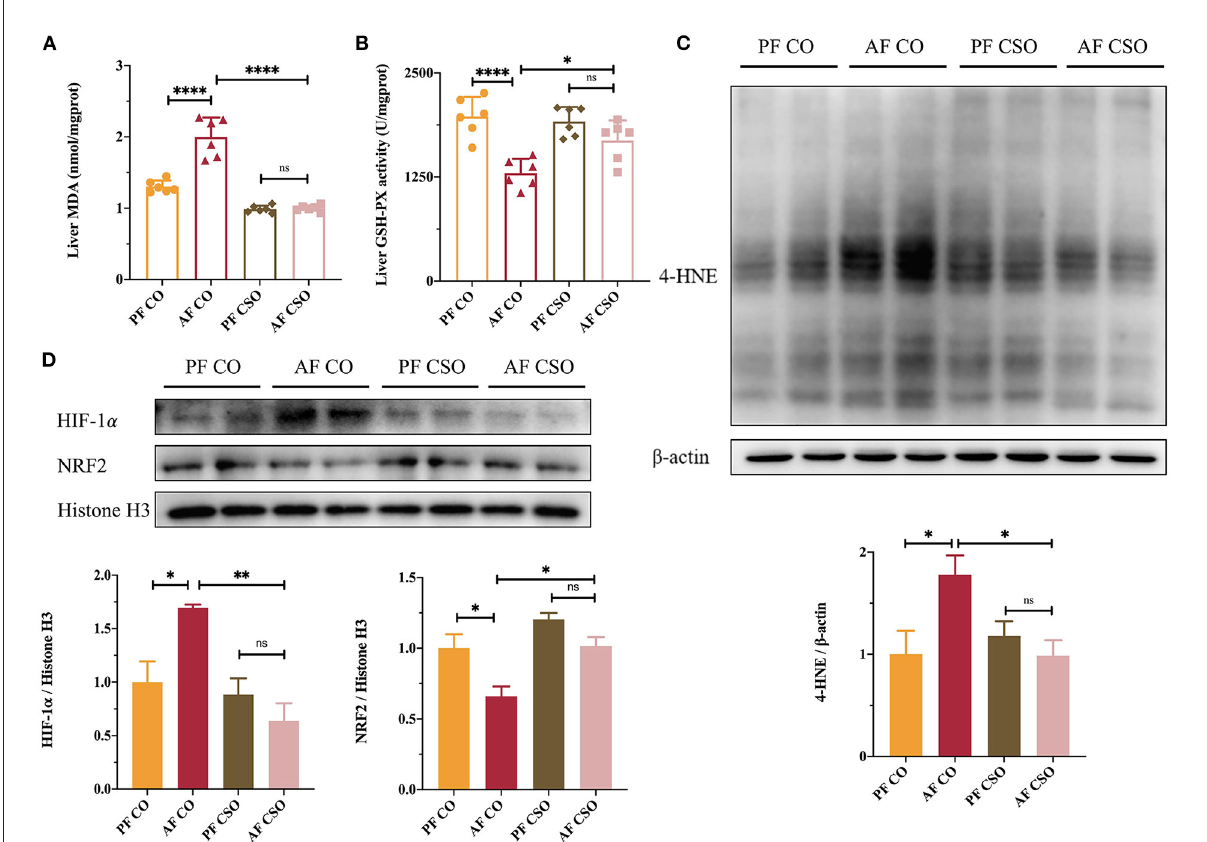
FIGURE2 Dietary CSO supplementation alleviates alcohol-induced hepatic oxidative stress. The activity of (A) MDA and the level of (B) GSH-PX in livers. (C) The expression of hepatic 4-HNE. (D) The nucleoprotein expressions of hepatic HIF-1 α and NRF2. * P < 0.05, ** P < 0.01, and **** P < 0.0001 indicate statistically significant